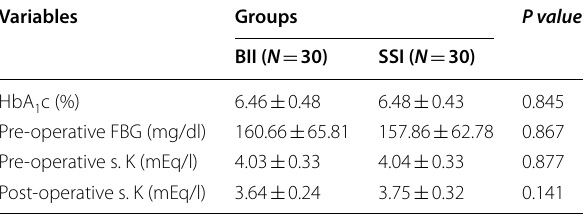
Data are presented as mean SD. P value > 0.05 is statistically non-significant. ± BII Bolus-insulin infusion group, SSI Sliding scale of insulin group, HbA1c Glycosylated hemoglobin, FBG Fasting blood glucose, s.k Serum